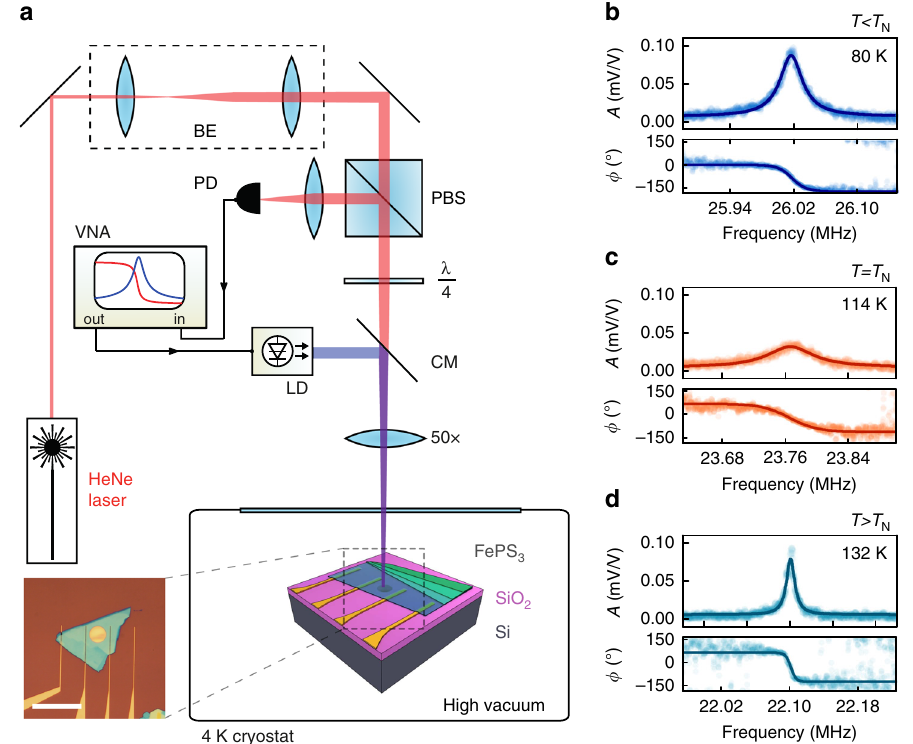
Fig. 1 Characterisation of mechanical resonances in a thin antiferromagnetic FePS 3 membrane. a Laser interferometry setup. Red interferometric detection laser: λ red = 632 nm. Blue actuation laser diode: λ blue = 405 nm. VNA, vector network analyzer, CM, cold mirror; PBS, polarizing beam splitter; PD, photodiode; LD, laser diode. Inset: optical image of a FePS 3 membrane, including electrodes introducing an option for electrostatic control of strain in the membrane. Flake thickness: 45.2 ± 0.6 nm; membrane diameter: d = 10 μ m. Scale bar: 30 μ m. b – d Amplitude ( A ) and phase ( ϕ ) of the fundamental resonance at three different temperatures for the device shown in ( a ). Filled dots, measured data; solid lines, fi t of the mechanical resonance used to determine f 0 and Q 17